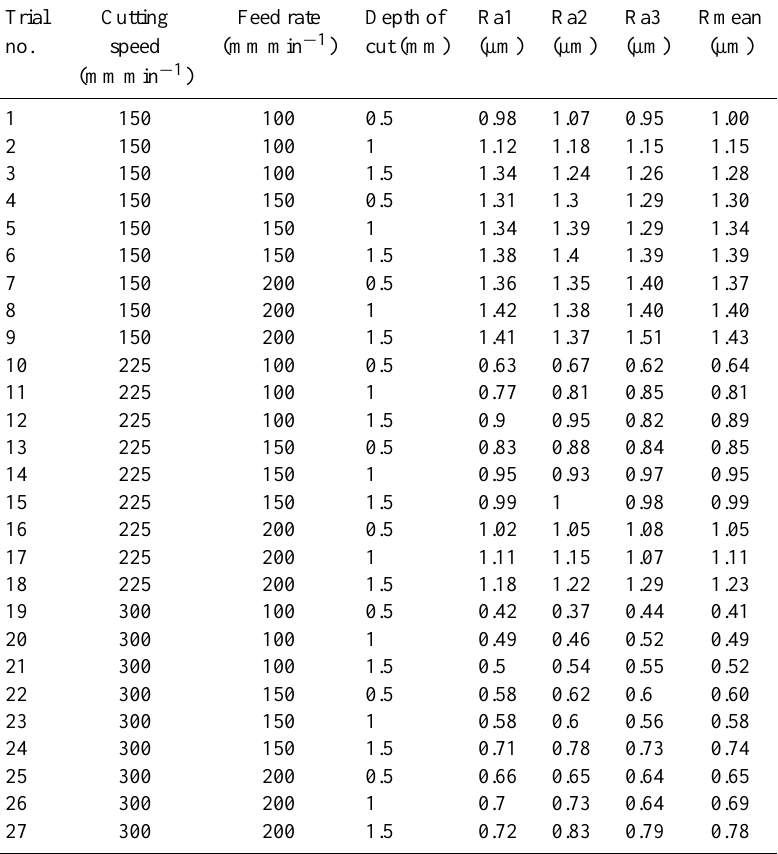
Table 4. The results of average surface roughness by full factorial method.